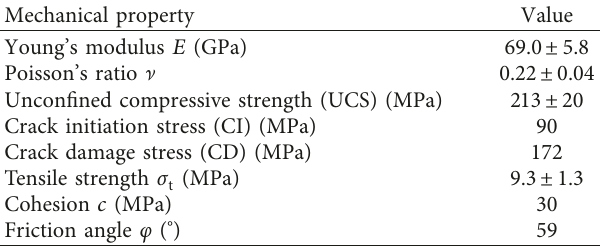
Table 3: Stress field conditions applied in the FDEM model in Irazu (negative values denote